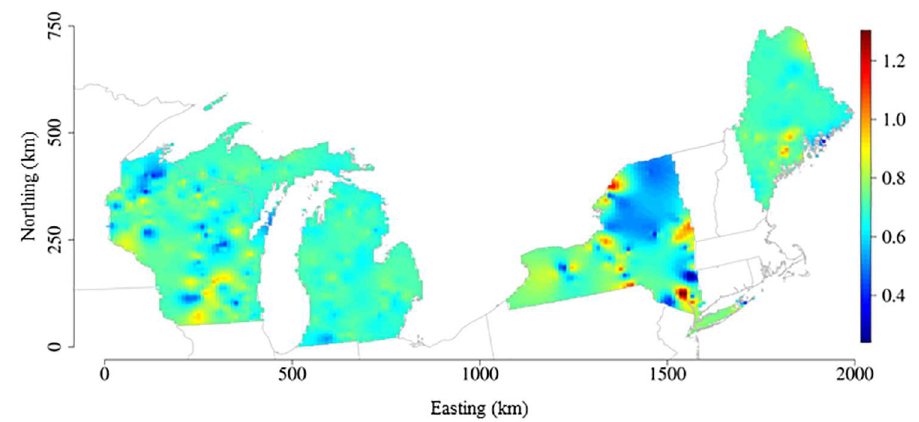
Fig 3. Spatially-varying TP–CHL coefficients maps derived from the SVC FULL model. Surface map of spatially-varying TP–CHL relationships created by interpolationof the posterior mean values that were estimated by lake location in the model buildingdataset (N = 779). Blue to red color gradient represents low to high TP–CHL coefficient